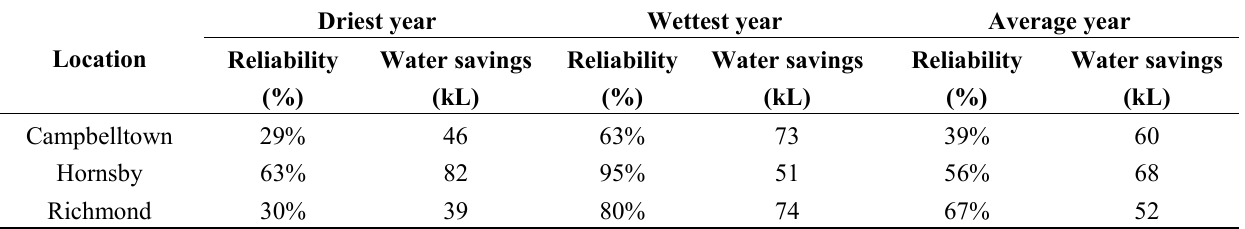
Table 6. Reliability and water savings at Campbelltown, Hornsby and Richmond for a 5kL rainwater tank for combined use for the driest, wettest and average years on